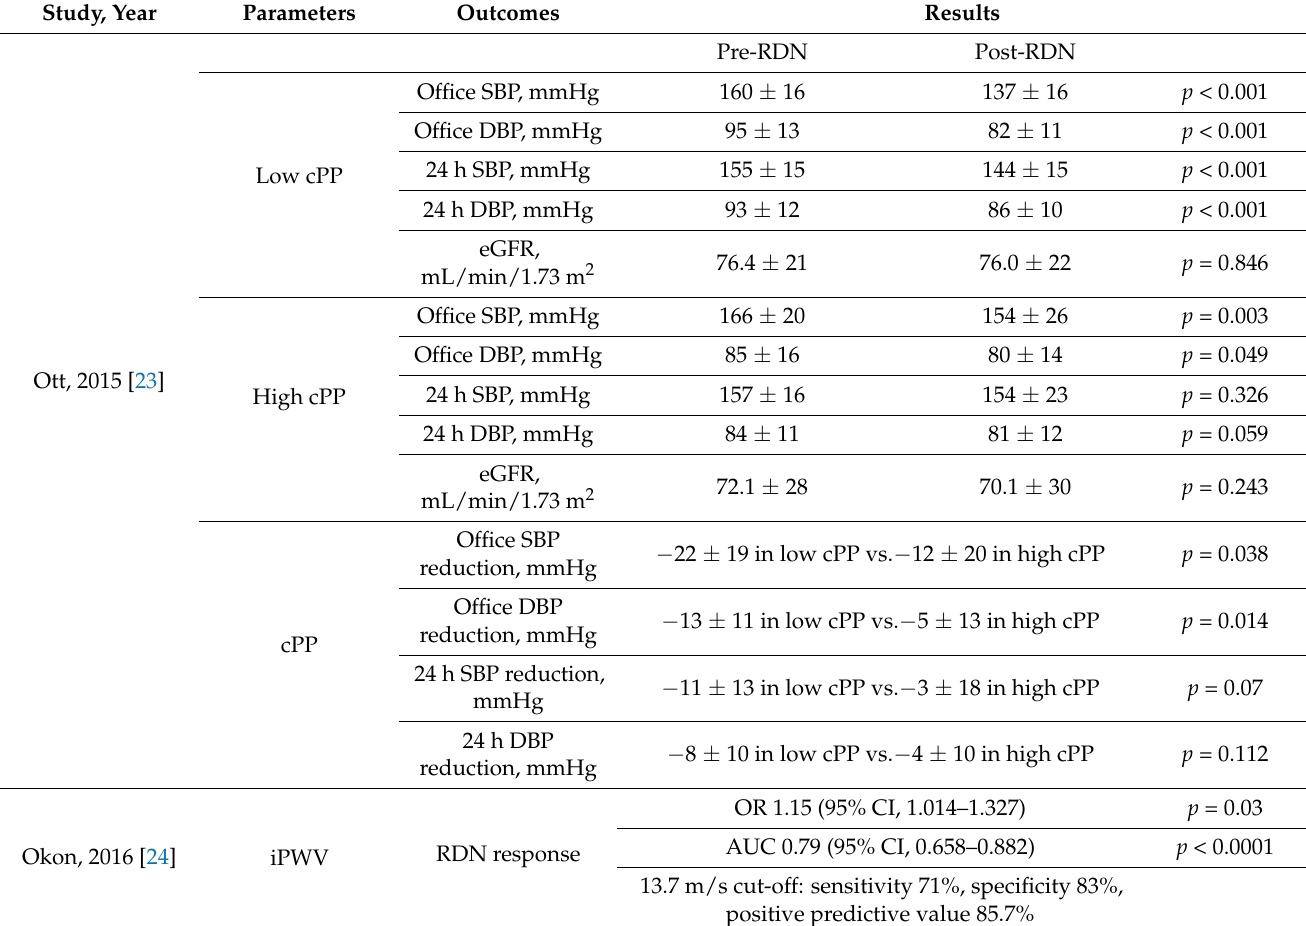
Table 2. Results reported in clinical studies included in the present systematic